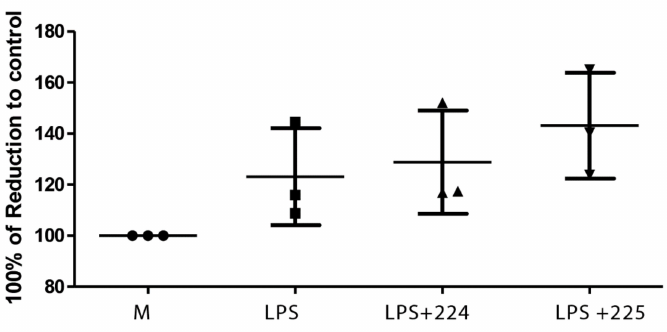
Figure 6. The e ff ect of UK propolis on the viability of LPS-stimulated macrophages measured by using an Alamar blue assay